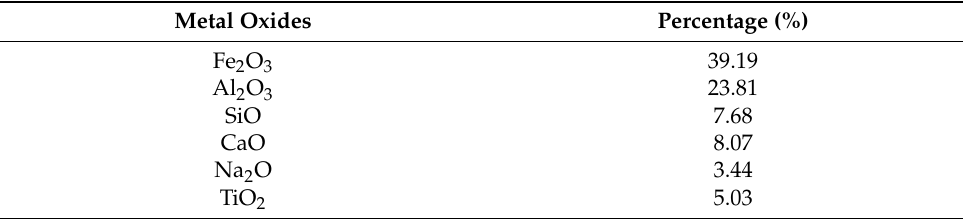
Table 1. Chemical composition of bauxite residue analyzed by the XRF method at AOG. Metal